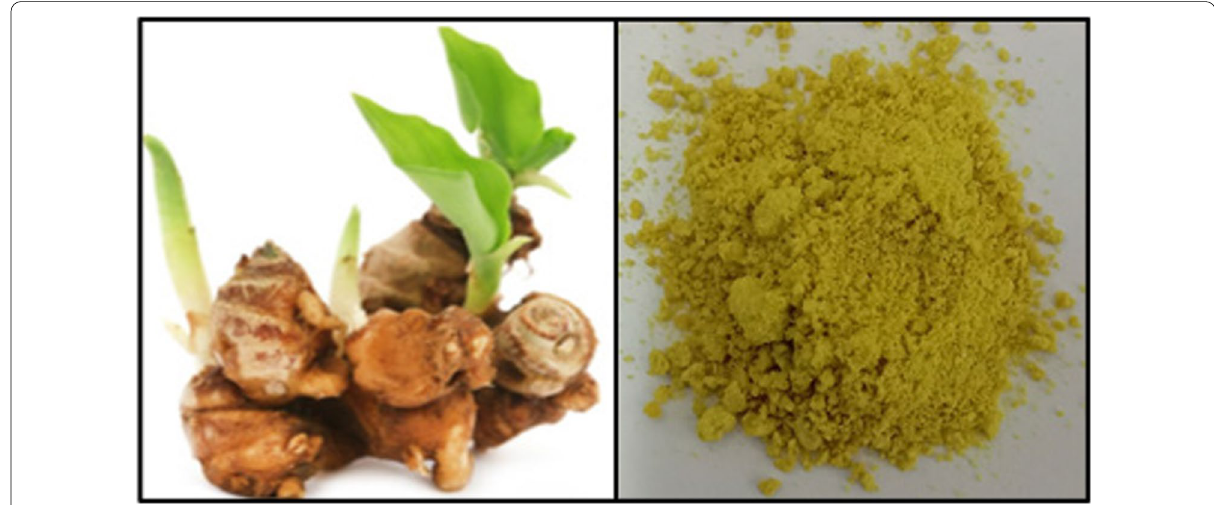
Fig. 6 Kaempferia galanga rhizome and crude ethanolic